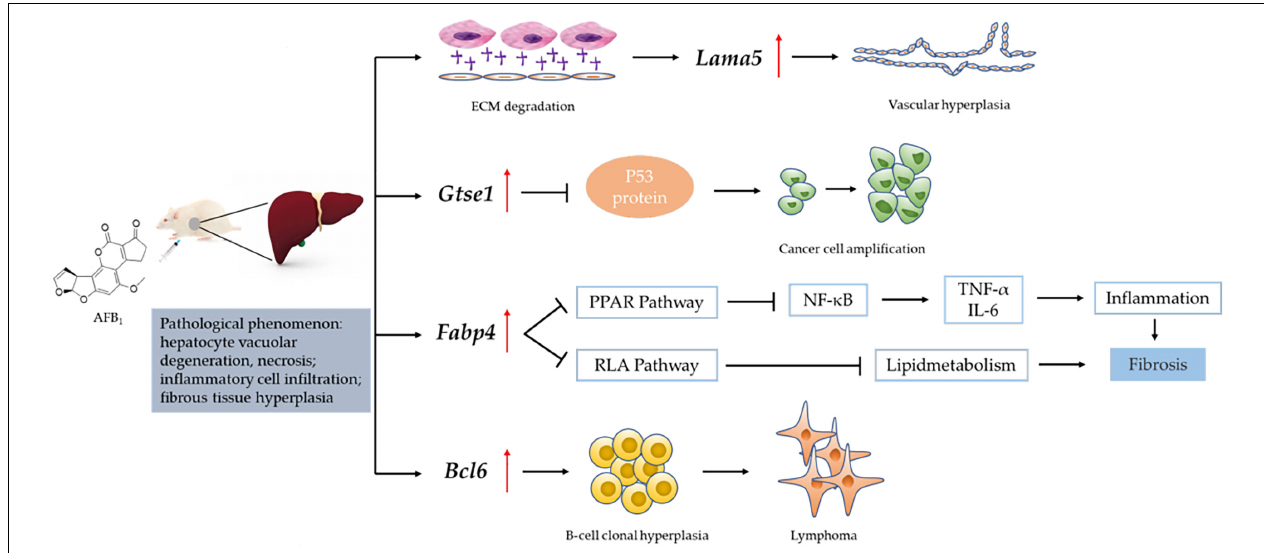
FIGURE 7 | Mechanism of liver injury induced by Lama5 , Gtse1 , Fabp4 , and Bcl6 genes. RAF: Regulation of lipolysis in adipocytes; ECM: Extracellular matrix; “ ”: vascular endothelial growth factor (VEGF); “ ”: promote/up-regulate; “ ”: